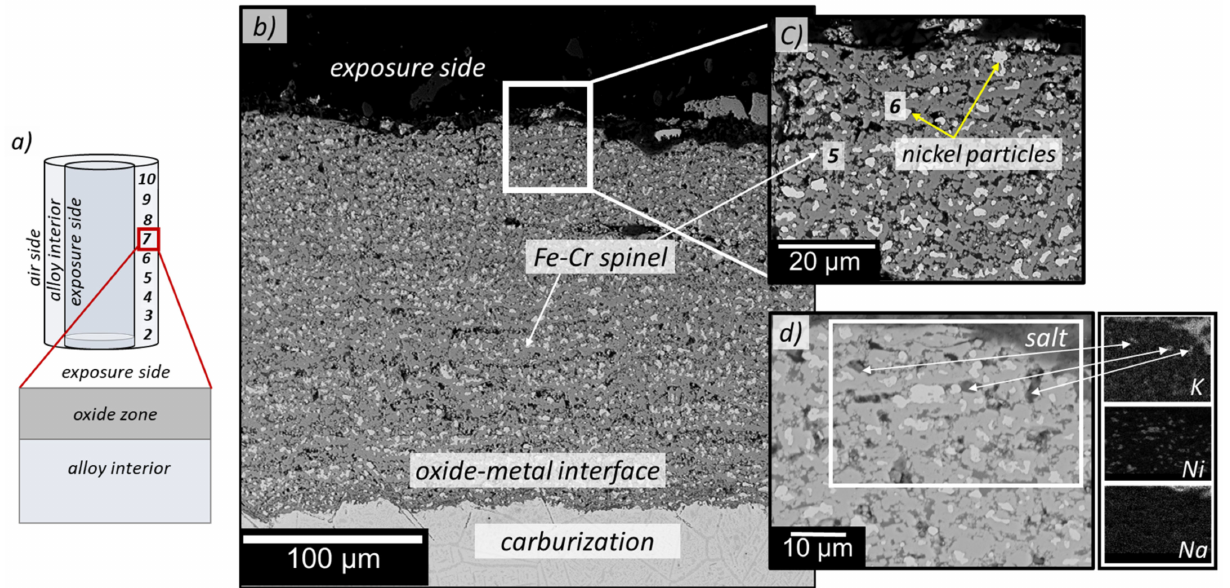
Figure 5. ( a ) Schematic illustration of the vessel highlights the main corrosion regimes in the middle-temperature section after 4000 h exposure to evaporated alkali carbonate species. ( b ) Low- magnification BSE image of sample #3 showing oxide layer and carburization beneath oxide-metal interface. ( c ) High-magnification of image ( b ) presenting the oxide scale on sample #7 comprising Fe-Cr spinel and nickel particles. ( d ) K, Ni, and Na EDS element maps showing potassium species incorporated in the oxide